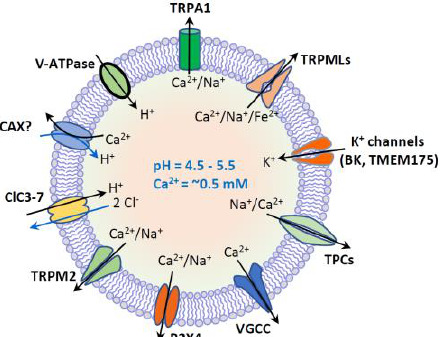
Figure 2. Lysosome ion homeostasis and ion channels. The lysosome has an acidic lumen that contains soluble hydrolytic enzymes. The activity of hydrolytic enzymes is controlled by intraluminal ion homeostasis that is established by multiple ion channels and transporters. These ion channels and transporters include H + -ATPase, nonselective cation channels (TRPML1-3, TRPM2, TRPA1 and P2 × 4), Na + or Na + /Ca 2+ -selective two-pore channels (TPC1-3), voltage-gated Ca 2+ channels (VGCC), K + - selective channels (BK and TMEM175), and 2Cl − /1H + exchanger or Cl − channels (ClC3-7). Putative Ca 2+ /H + exchanger (CAX) or Ca 2+ transport protein mediates lysosomal uptake of Ca 2+ .